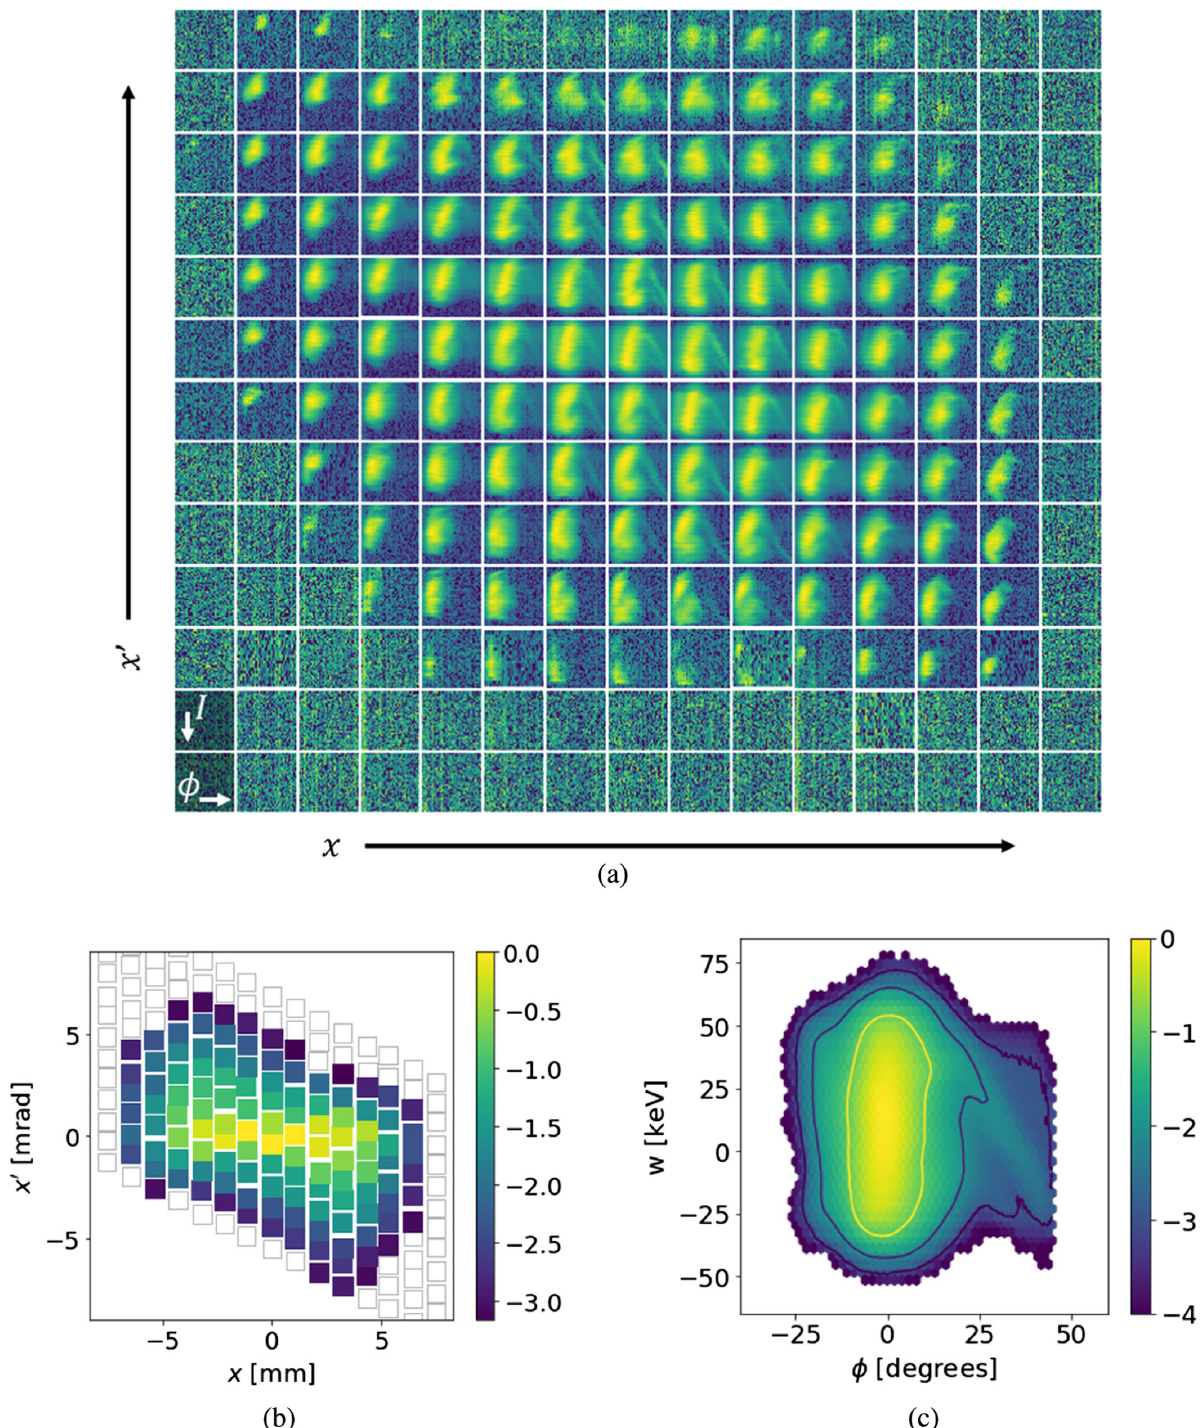
FIG. 12. Data from a 4D scan with BSM wire positioned for peak signal strength near the core of the beam. (a) Minimally-processed ˆ f ð x; x 0 ; ϕ ; I Þj w can be calculated through matrix transformation of x; x 0 and dipole current I . Each data from the 4D scan of ˜ y 2 . Energy ˆ f ð ϕ ; I Þj I and horizontal axis ϕ . The axis limits are held fixed for all subplots, but frame shows a partial projection ˜ x; ˜ x 0 , with vertical axis the color scale is not. Each sub-frame corresponds to a different location in x; x 0 . Color is signal strength in logarithmic scale. Data has been cleaned of spurious signals and averaged. (b) Image of the 4D scan along the x; x 0 axes, which are referenced to the location of the first vertical slit. The color of each point is the integrated signal in the ϕ ; w dimensions. Points with no signal above 10 − 3 . 22 threshold are ˆ f ð ϕ ; w Þj not filled. The intensity scale is logarithmic. (c) Longitudinal phase space ˜ y 2 generated by integrating frames in (a) over the horizontal coordinates, Contour levels are shown at 0.1%, 1% and 10% of